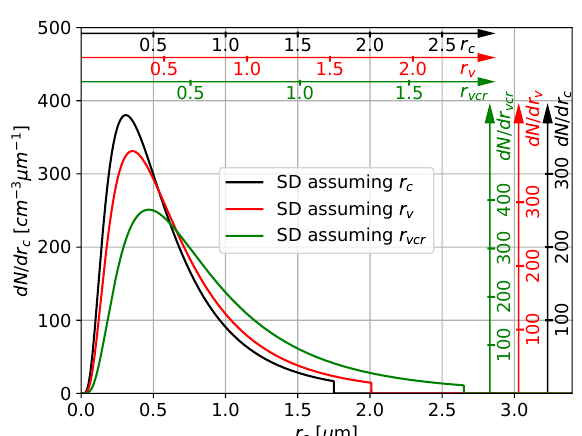
Figure 8. Lognormal size distributions (SD) with same r mod , σ , N 0 , and r max assuming different size equivalences for aggregate particles (shape D, ξ vc = 0 . 8708) as applied in Table 5. The size distributions are plotted in terms of cross-section-equivalent sizes (i.e., d N/ d r c (r c ) referring to black axes and grid). For comparison axes valid for the other size interpretations are also plotted in red and green, which allows each size distribution to be interpreted in terms of each size